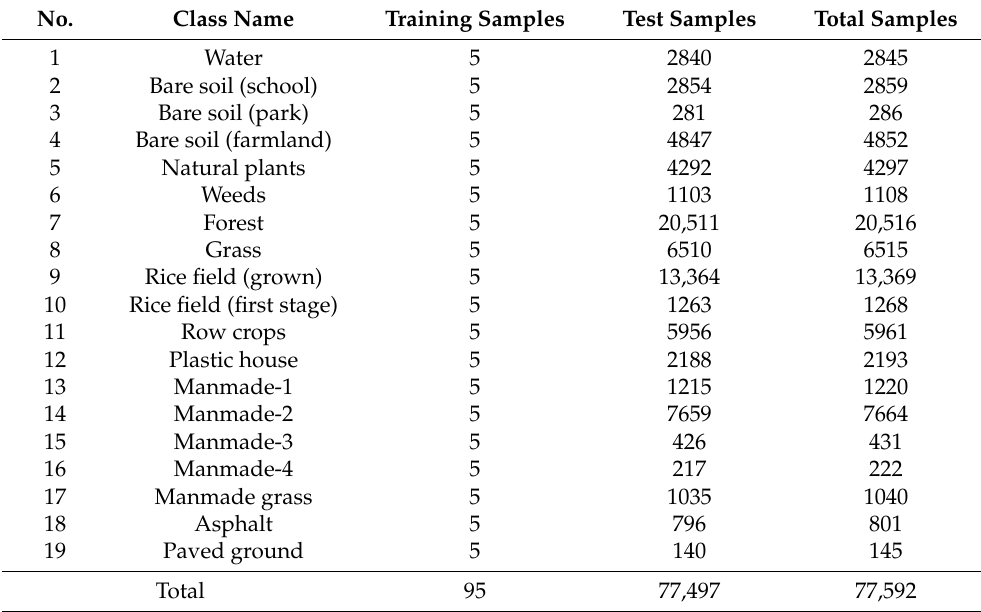
Table 4. Land cover classes and numbers of samples in the Chikusei dataset.